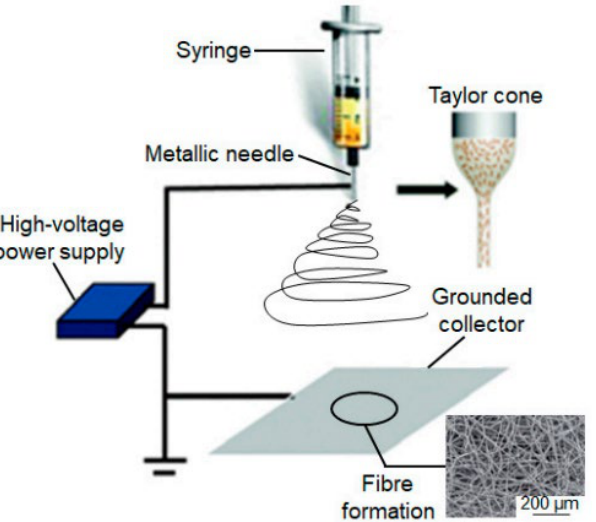
Figure 2. The main electrospinning mechanism and equipment. The usual electrospinning setup is depicted schematically in this diagram, reproduced from [14].